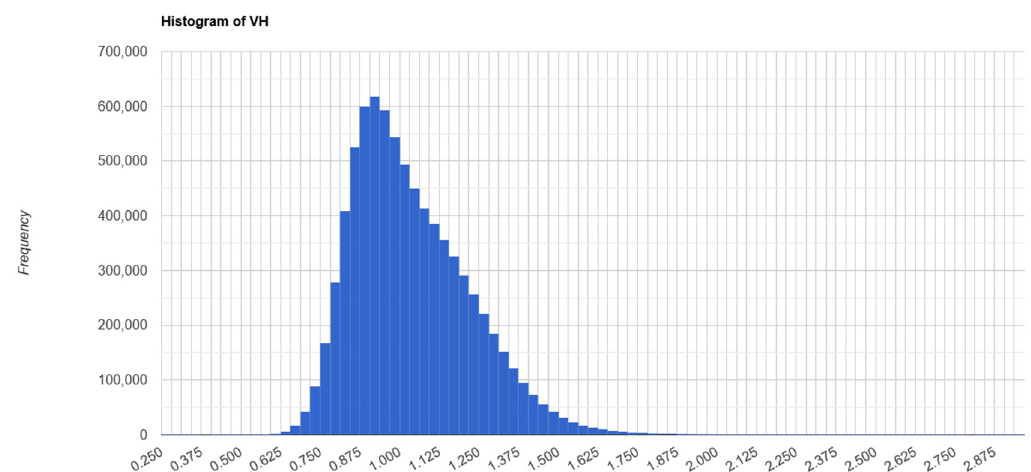
Remote Sens. 2021 , 13 , x FOR PEER REVIEW Figure 10. Histogram of VH difference showing just one major peak. Figure 10. Histogram of VH difference showing just one major peak.